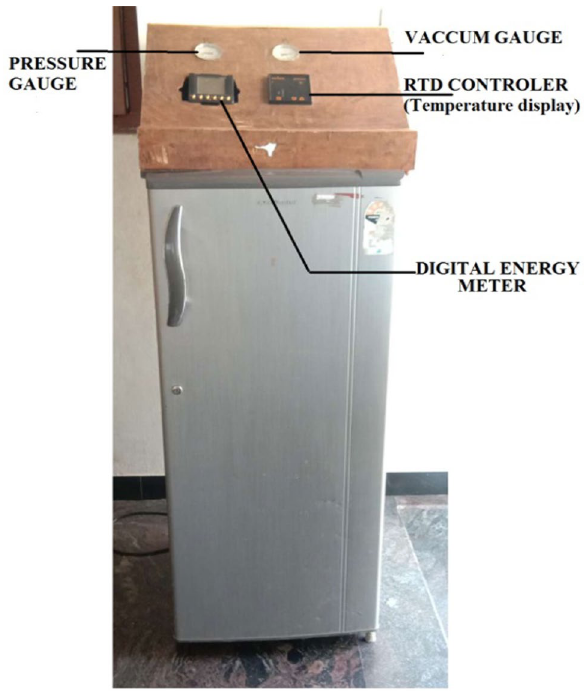
Figure 1. View of the experimental set.